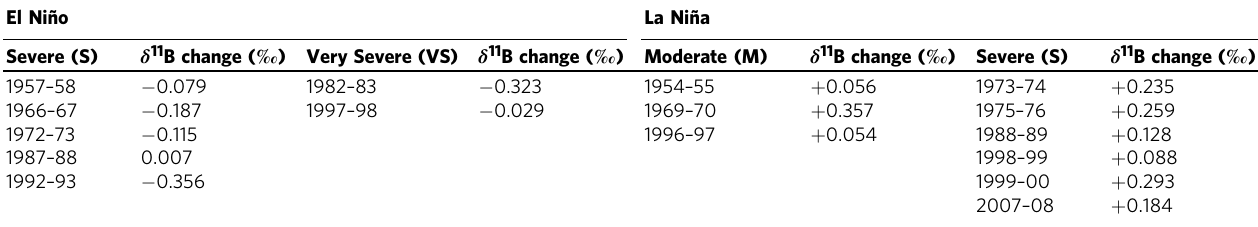
Table 2 ENSO events from Oceanic Niño Index